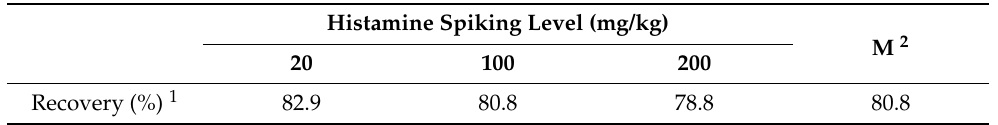
Table 2. Recovery data for the method for analysis of histamine in tuna samples spiked at 3 concen- tration